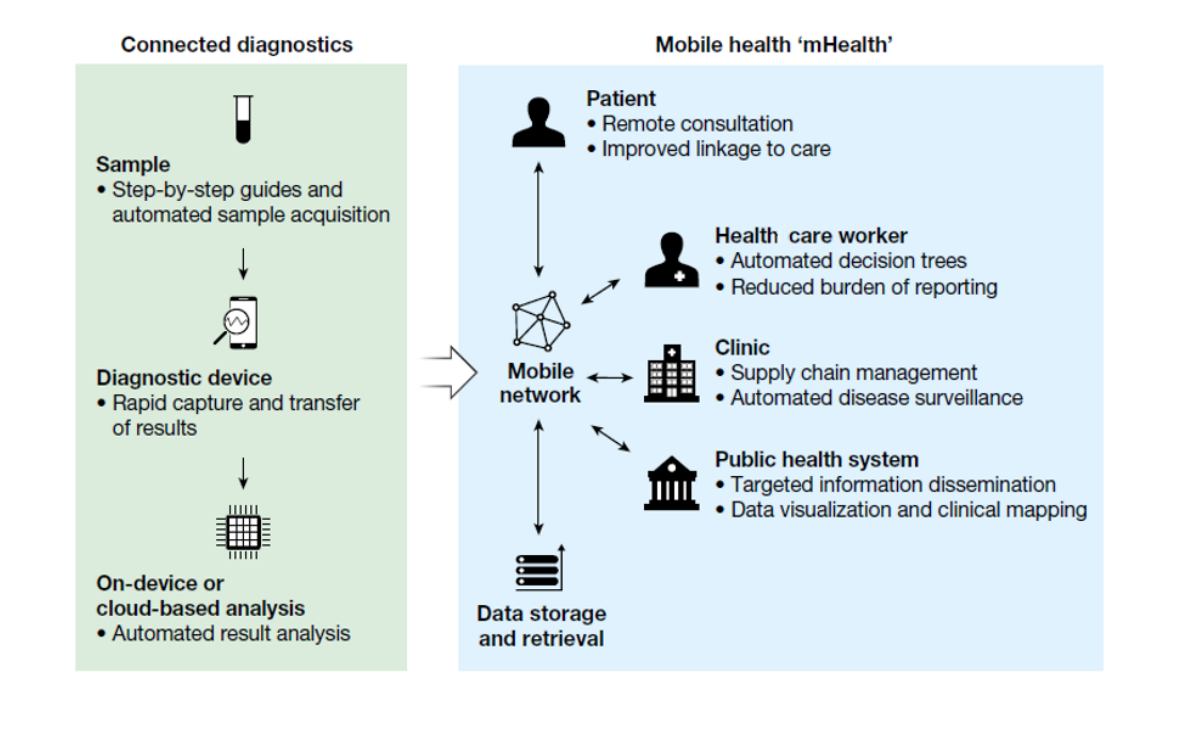
Figure 1. Mobile health–connected diagnostics by Wood et al,